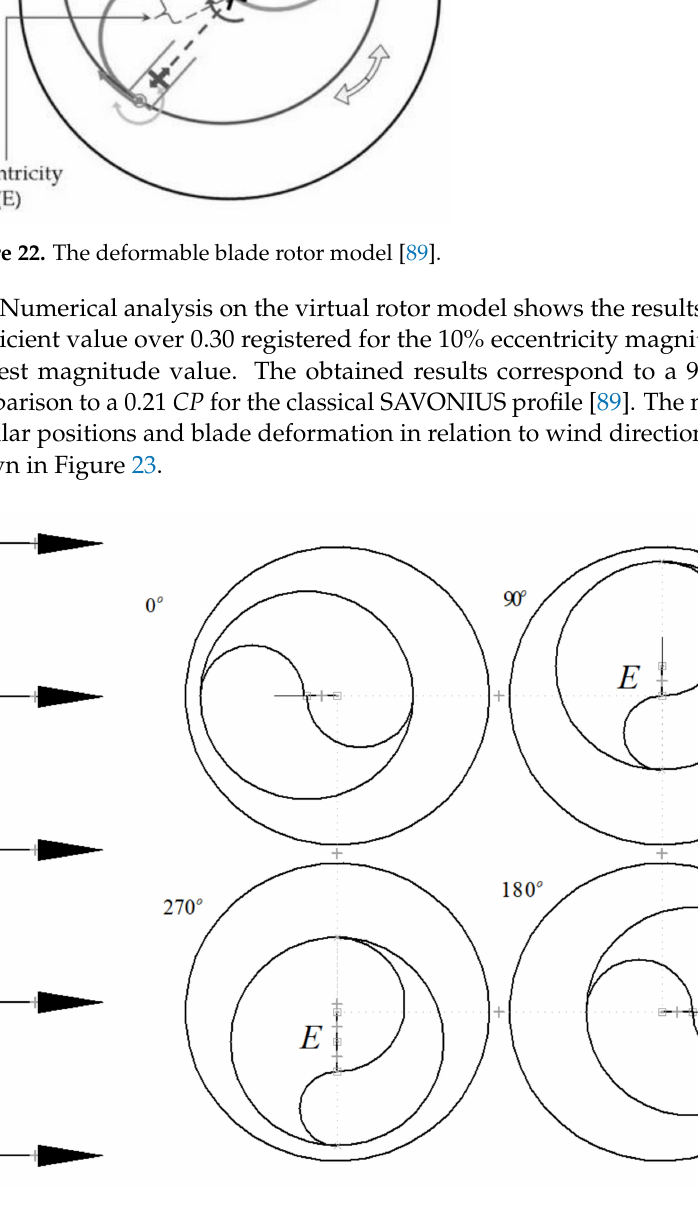
Figure 23. The SAVONIUS rotor with deformable blades in relation to eccentricity and different angular positions